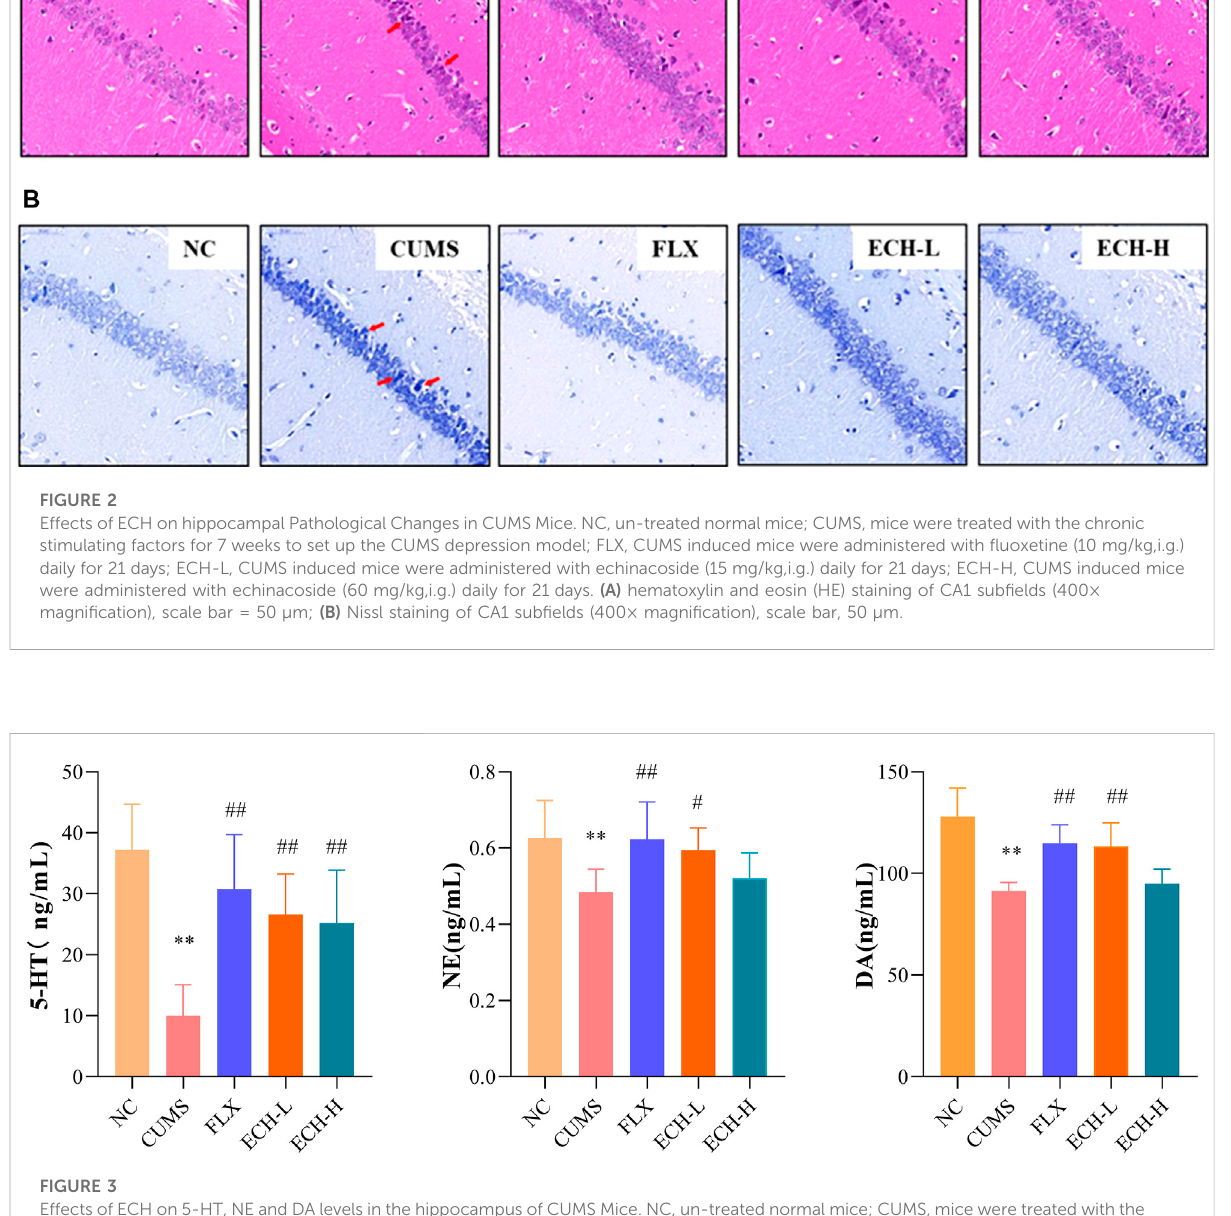
CUMS group, CRH, ACTH, and CORT levels of the echinacoside groups (15 mg/kg and 60 mg/kg) were signi fi cantly decreased.